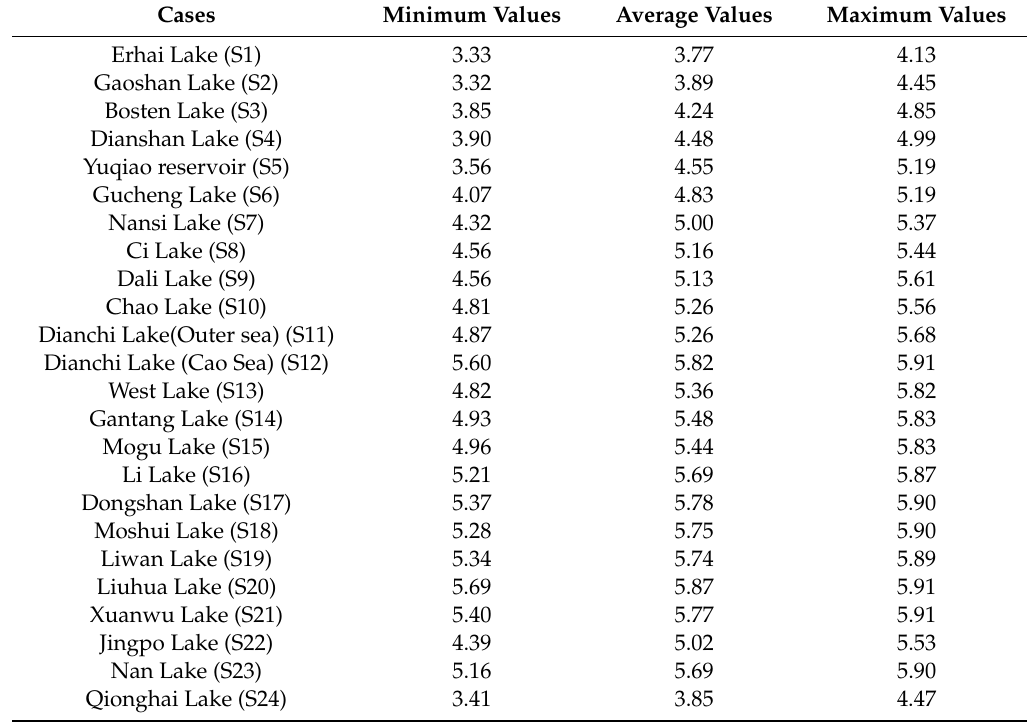
Table 6. Non-integral eutrophication grade rank feature of each lake.